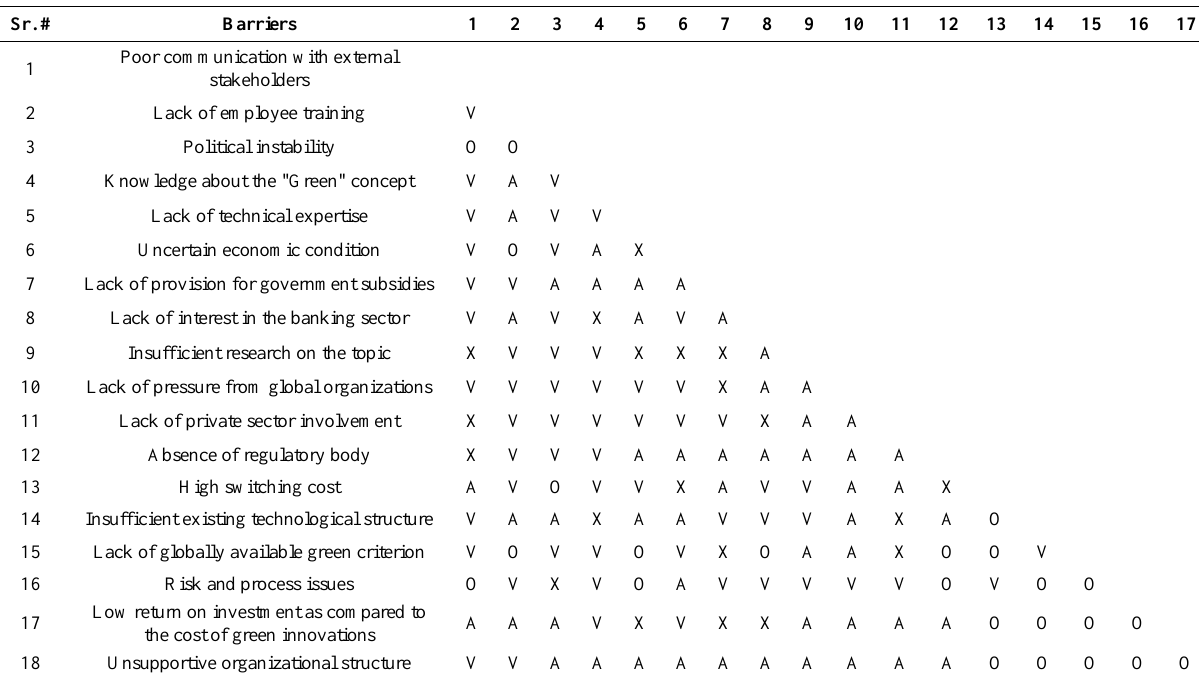
Table 4. Structural self-interaction